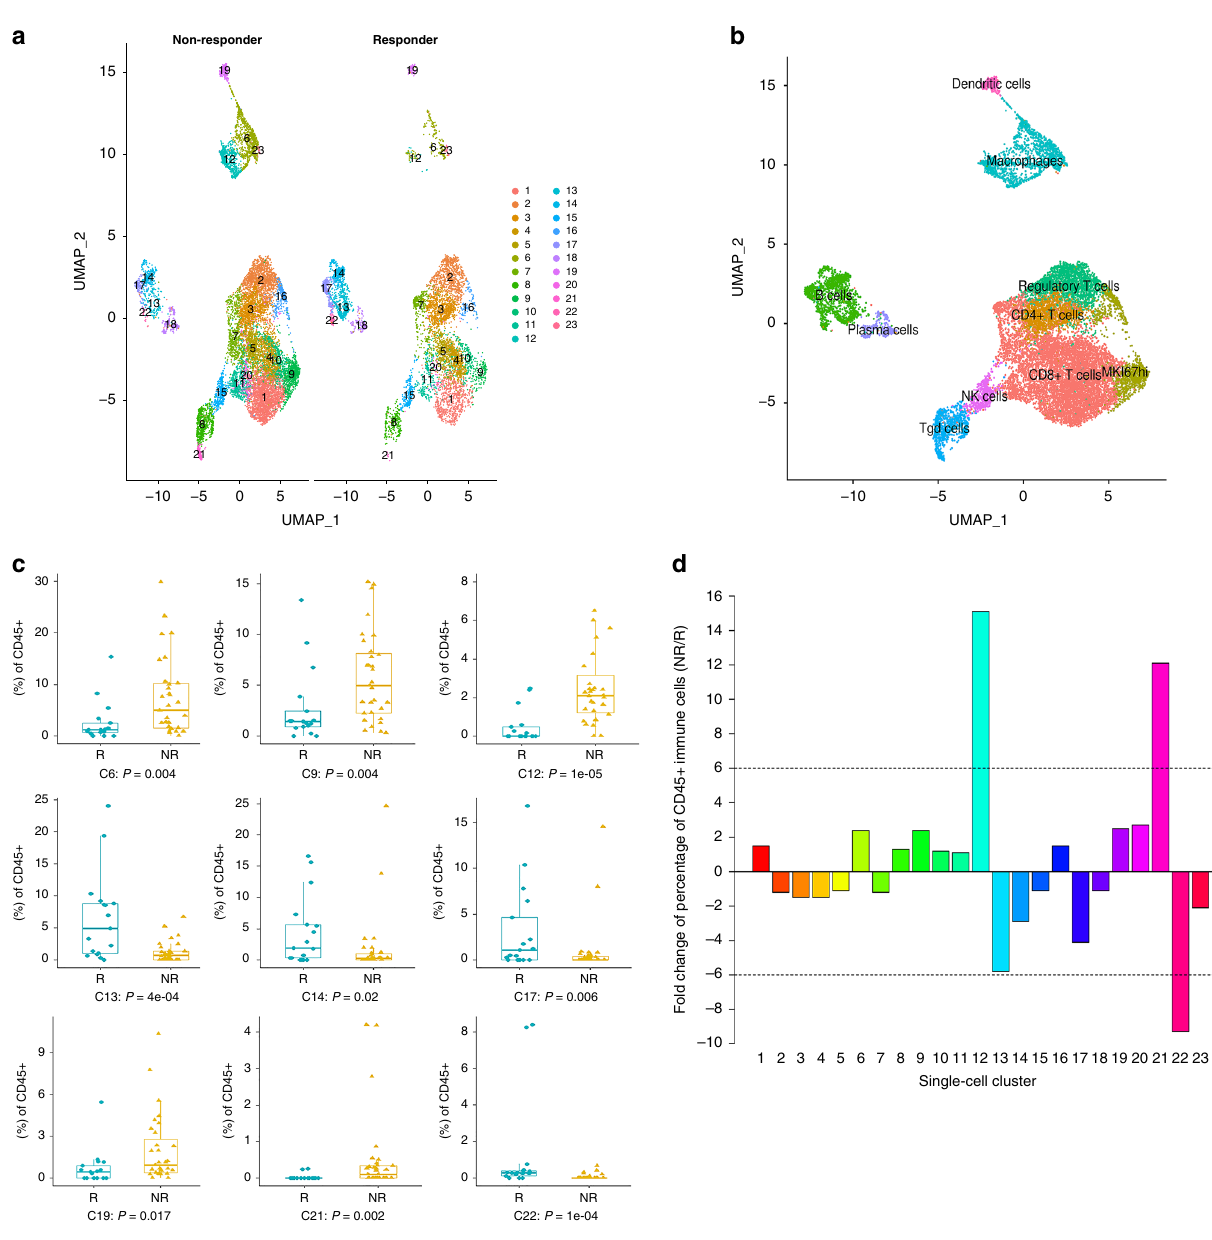
Fig. 1 Identi fi cation of intratumoral immune cell populations by scRNA-seq. The scRNA-seq dataset - GSE120575 was analyzed. a Uniform manifold approximation and projection (UMAP) plot of intratumoral immune cells that were classi fi ed into 23 clusters from the two groups of melanoma samples of distinct immune checkpoint therapy outcomes (NR [non-responder] group versus R [responder] group). b UMAP plot of the 10 major immune cell populations. c Comparison of the cell cluster percentage changes between the NR and R groups. Boxplots showed the results for the nine immune cell clusters with signi fi cant changes. Center line, median. Box limits, upper and lower quartiles. Whiskers, 1.5 interquartile range. Points beyond whiskers, outliers. The two-sided Wilcoxon tests were performed with no adjustment for multiple comparisons. d The fold changes of the percentages of each of the 23 single-cell clusters comparing the NR group to the R